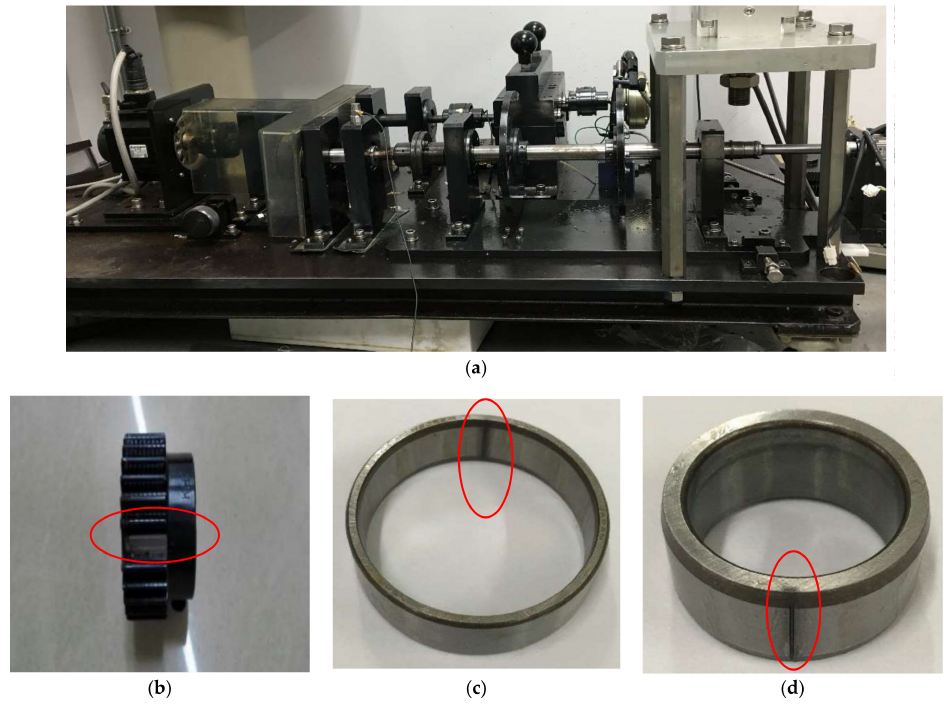
Figure 6. Experimental system, ( a ) experimental table, ( b ) gear broken-tooth fault, ( c ) bearing outer-race fault, and ( d ) bearing inner-race